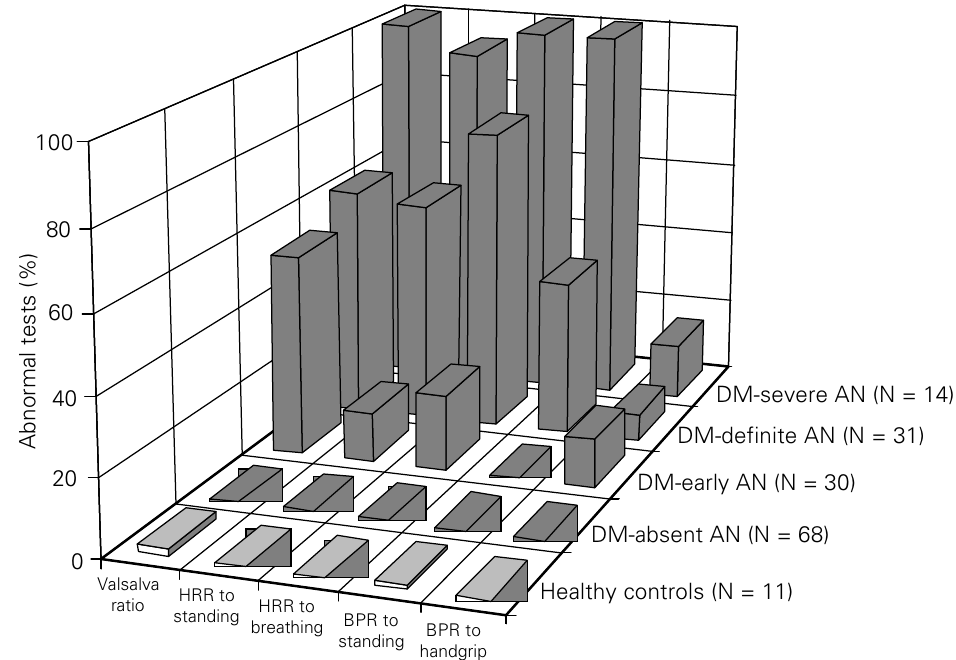
Figure 4 - Abnormal results ob- served in heart rate response (HRR) and blood pressure re- sponse (BPR) tests of healthy subjects and diabetic patients with different degrees of auto- nomic neuropathy (AN). Data are reported as percent of abnormal results for the number of per- sons in each group indicated within parentheses. Responses were calculated using the com- puterized method. DM, Diabe- tes